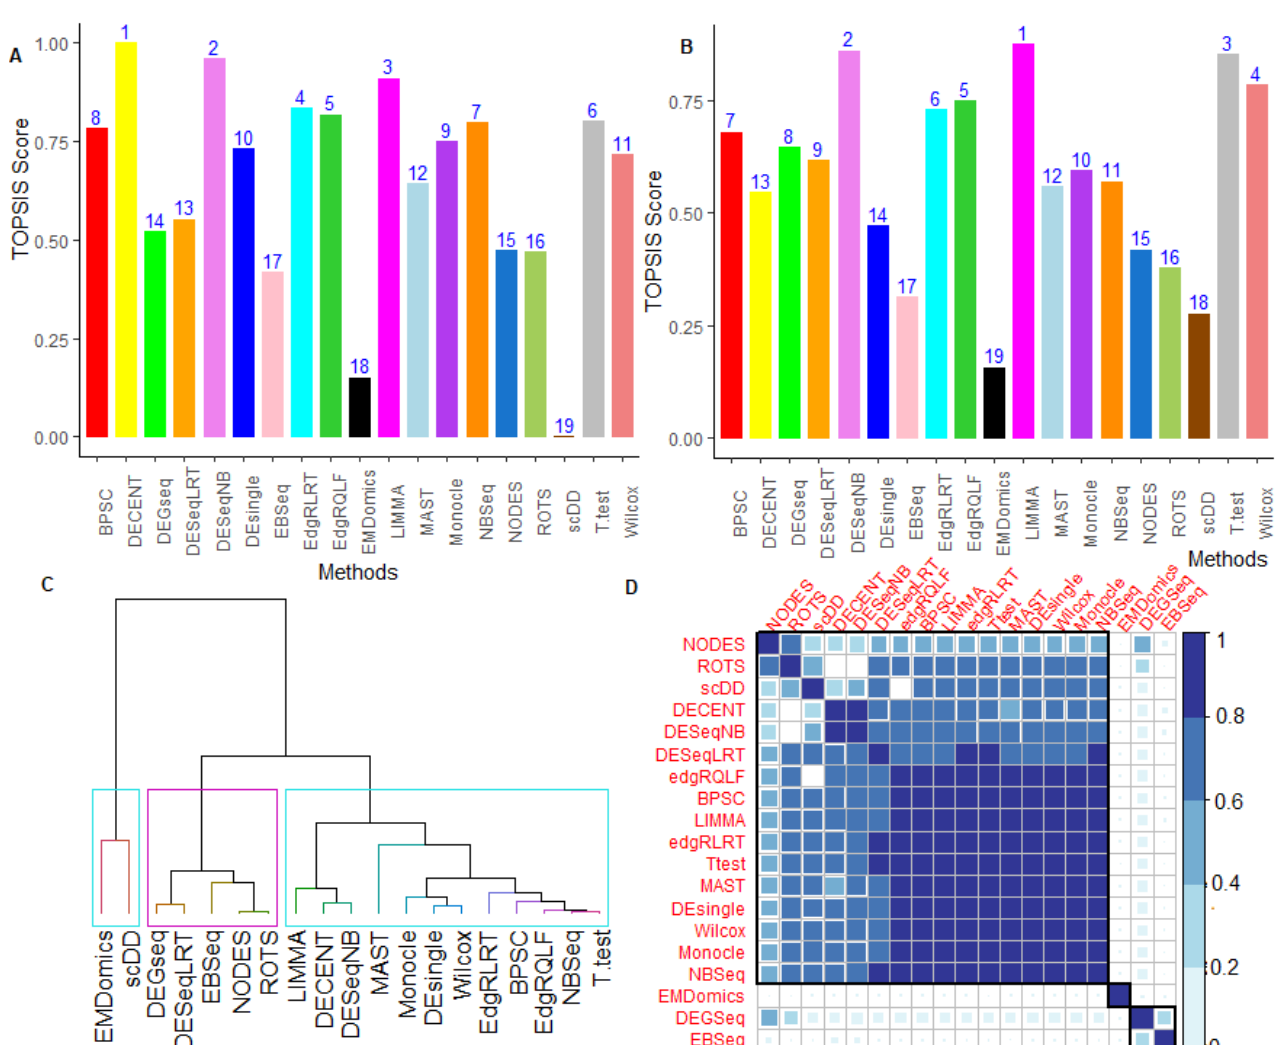
Figure 3. Performance evaluation of methods under MCDM setup for Soumillion2 data. Comparative performance analysis of 19 tested methods was carried out through the TOPSIS approach under MCDM setup on the Soumillion2 dataset. MCDM ‐ TOPSIS analysis was carried out under ( i ) multi ‐ criteria including runtime criterion; ( ii ) multi ‐ criteria excluding runtime criterion. X ‐ axis represents tested methods and Y ‐ axis represents TOPSIS scores. The results from the ( A ) MCDM ‐ TOPSIS analysis of the DE methods are shown for 12 performance metrics excluding runtime criterion; ( B ) MCDM ‐ TOPSIS analysis of the methods based on 13 performance metrics including runtime criterion; ( C ) Average similarities between evaluated DE methods based on 13 ‐ performance metrics. The dendrogram was obtained by average ‐ linkage hierarchical clustering based on matrix of average values of performance metrics over all gene sets; ( D ) Similarity analysis among the methods based on their ability to detect common DE genes. The p ‐ values for each comparison were computed through the Binomial test (Supplementary Document S12). Significant proportions (at 1% level of significance) of common genes shared among the methods are shown in various colors and white empty cells represent non ‐ significant values.